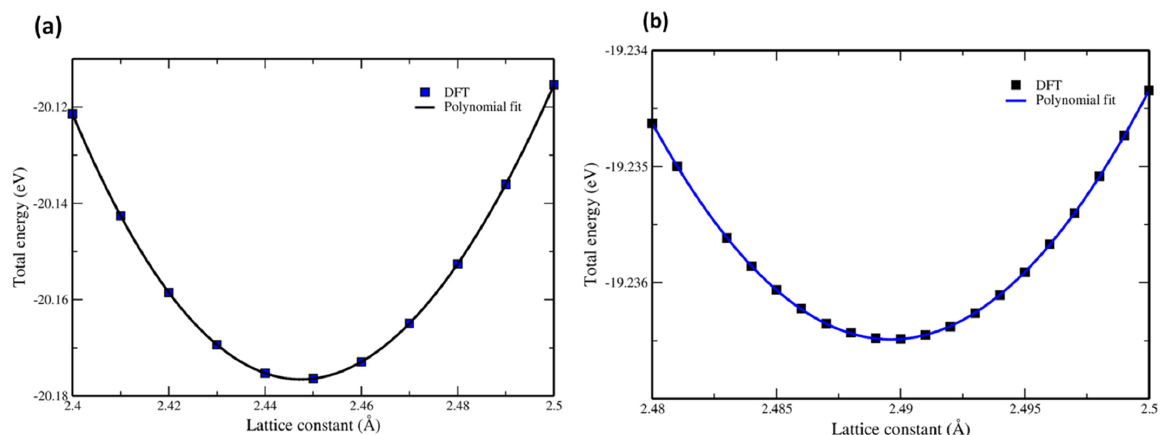
Figure 5. Optimized energy versus lattice constant curves of ( a ) graphene and ( b ) h-BN, calculated at the LDA level without zero-point energy. The smooth curves are polynomial fits, while the filled squares are total energies from DFT.